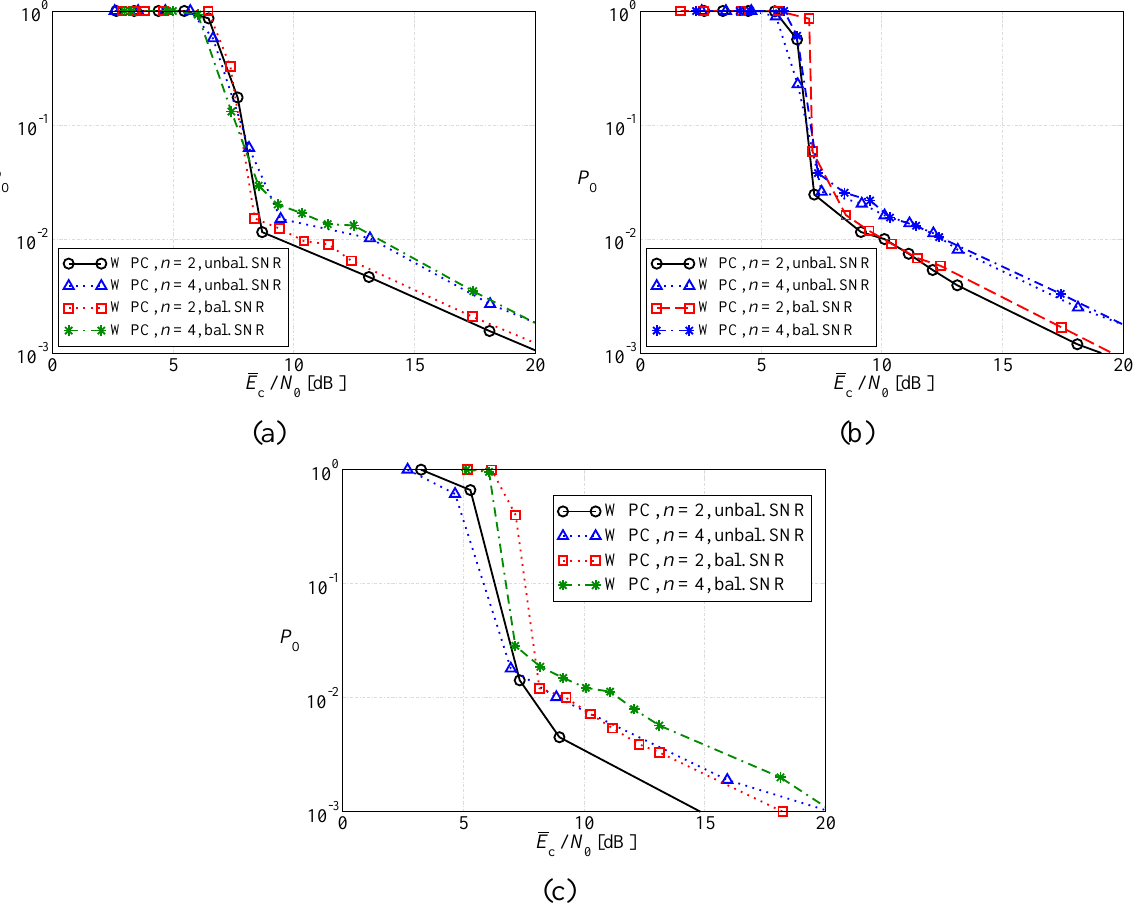
Figure 8. Outage probability, as a function of the average SNR at the sources, considering: (a) regular LDPC-coded schemes, (b) DD LDPC-coded schemes, and (c) SCCCed schemes. Both balanced SNR and unbalanced SNR power control strategies are